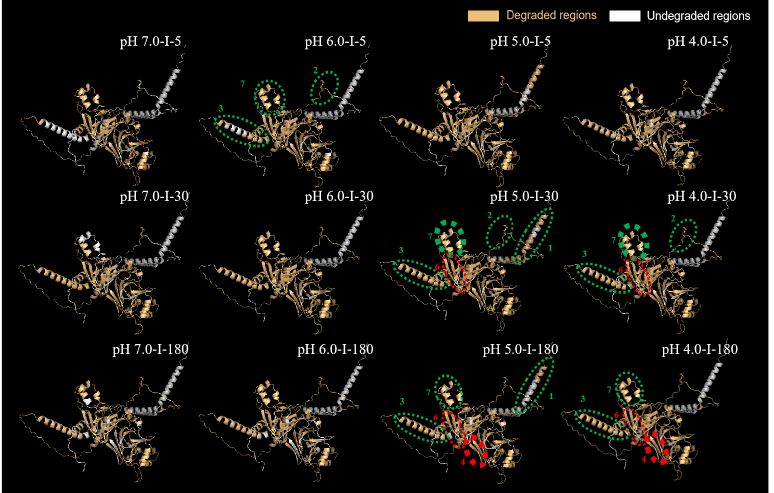
Figure 9. Distribution of gastrointestinal digestion sequence in the regions of the β - conglycinin α subunits in the FSPI digestates. I-5, I-30, and I-180 represent the gastrointestinal digestates collected from the artificial intestine at 5 min, 30 min, and 180 min, respectively.